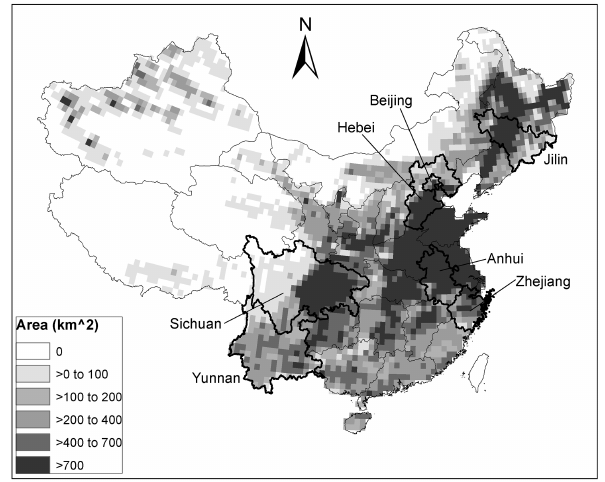
Figure 1. Map of China illustrating the surveyed provinces in bold over pixels showing density of square kilometers of total sown area of rice, wheat, maize and soy in 2000. Source: authors, using data from Qiu et al.